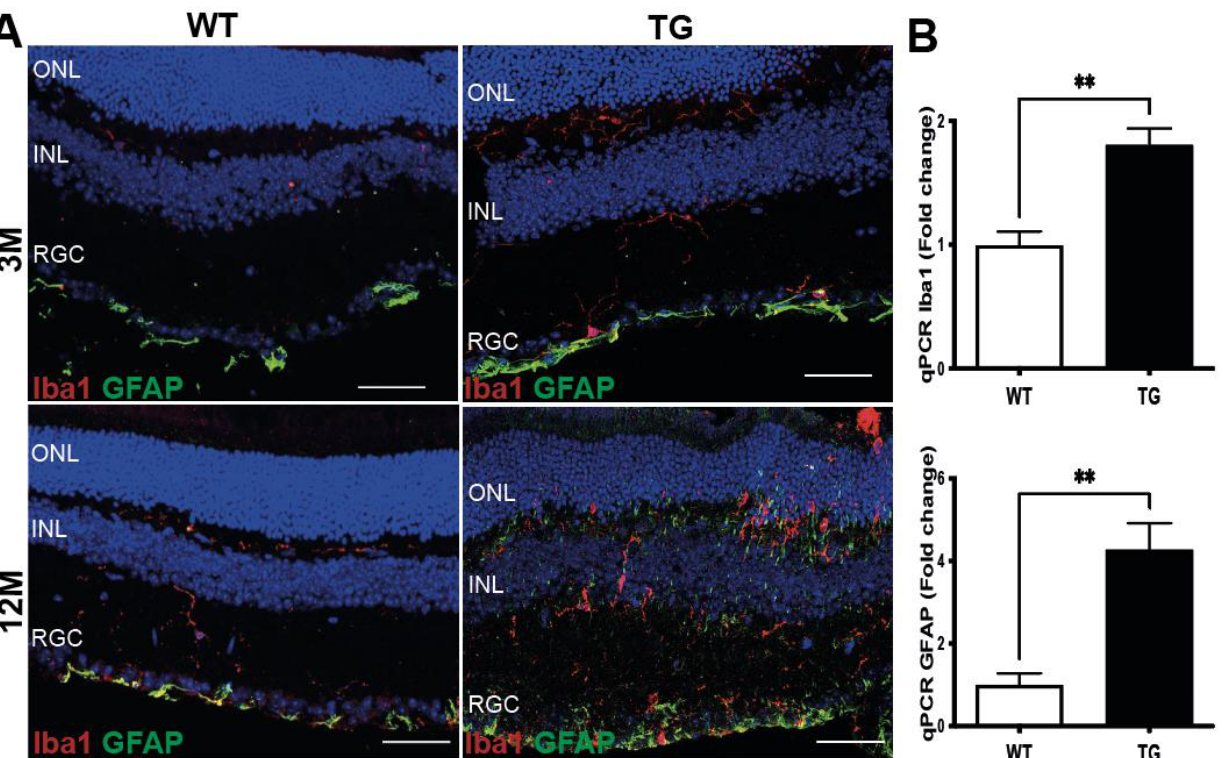
Figure 3. Gliosis in the retina of pre-symptomatic APP/PS1 mice. ( A ) Representative images of Iba1 and GFAP immunolabelling in the retina of TG APP/PS1 and WT mice aged 3 (upper panels) and 12 (lower panels) months. Scale bar = 50 µ m. ( B ) qPCR analysis of mRNA expression of iba1 and gfap in the retina of TG APP/PS1 and WT mice at 3 months. Results expressed as mean +/ − SEM. ** p < 0.01. qPCR quantification of both GFAP and Iba1: n = 6:3M + 3F for WT mice and n = 4:2M + 2F for TG mice at 3 months.